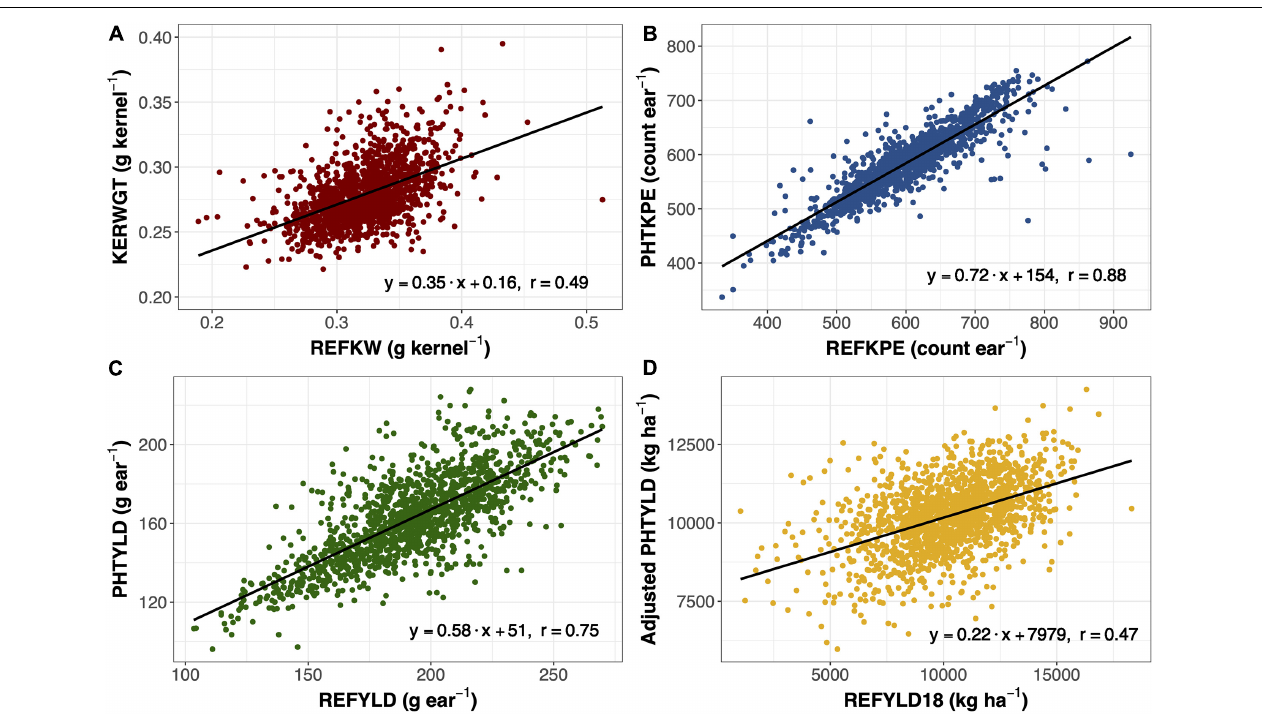
FIGURE 1 | Linear regression and Pearson correlation between reference kernel weight (REFKW) (x-axis) to photometry-estimated kernel weight (KERWGT) (y-axis) in 2017 ( n = 1,413) (A) . Linear regression and Pearson correlation between reference kernels per ear (REFKPE) (x-axis) to photometry-estimated kernels per ear (PHTKPE) (y-axis) in 2017 ( n = 1,413) (B) . Linear regression and Pearson correlation between reference yield (REFYLD) (x-axis) to photometry-estimated yield (PHTYLD) (y-axis) in 2017 ( n = 1,413) (C) . Linear regression and Pearson correlation between reference yield on a plot basis (REFYLD18) and the fitted values for PHTYLD adjusted for stand count in modeling REFYLD18 (REFYLD18 = PHTYLD + Stand Count) in 2018 ( n = 1,568) (D)